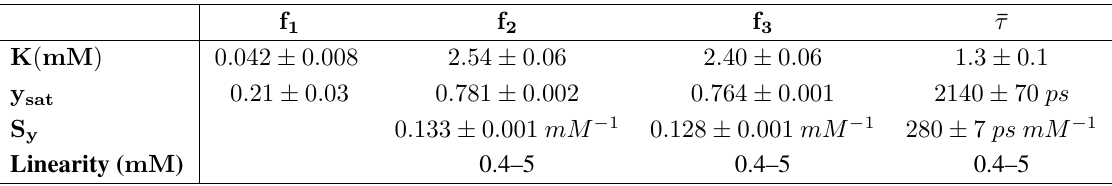
Table 2. Optokinetic parameters by Michaelis-Menten fitting of the time-resolved fluorescence parameters for the immobilized GOD .